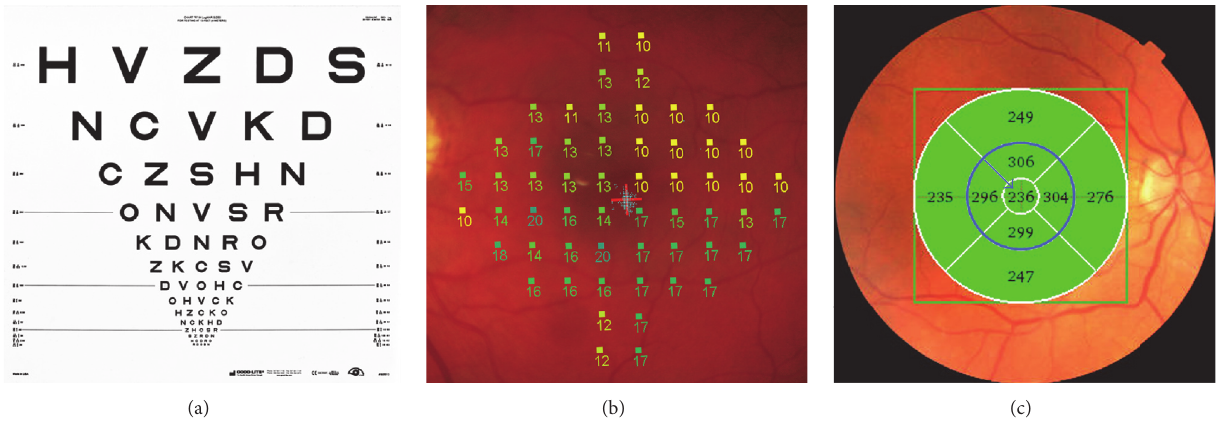
Figure 1: (a) ETDRS chart for best corrected visual acuity test. (b) Macular photography with the microperimetry test area. (c) Optical coherence tomography of macula and ETDRS rings thickness measurements, blue arrow to the central subfield, encircled blue central 5-field